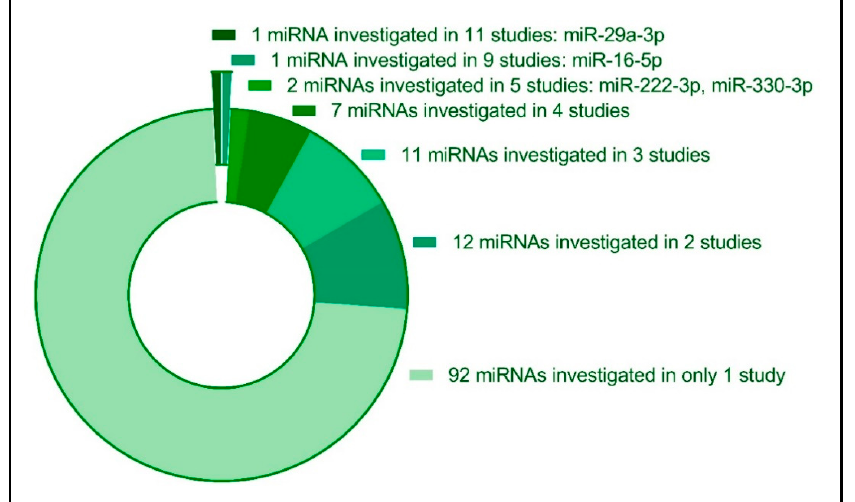
Figure 3. Diversity in the reported circulating miRNAs investigated in relation to GDM